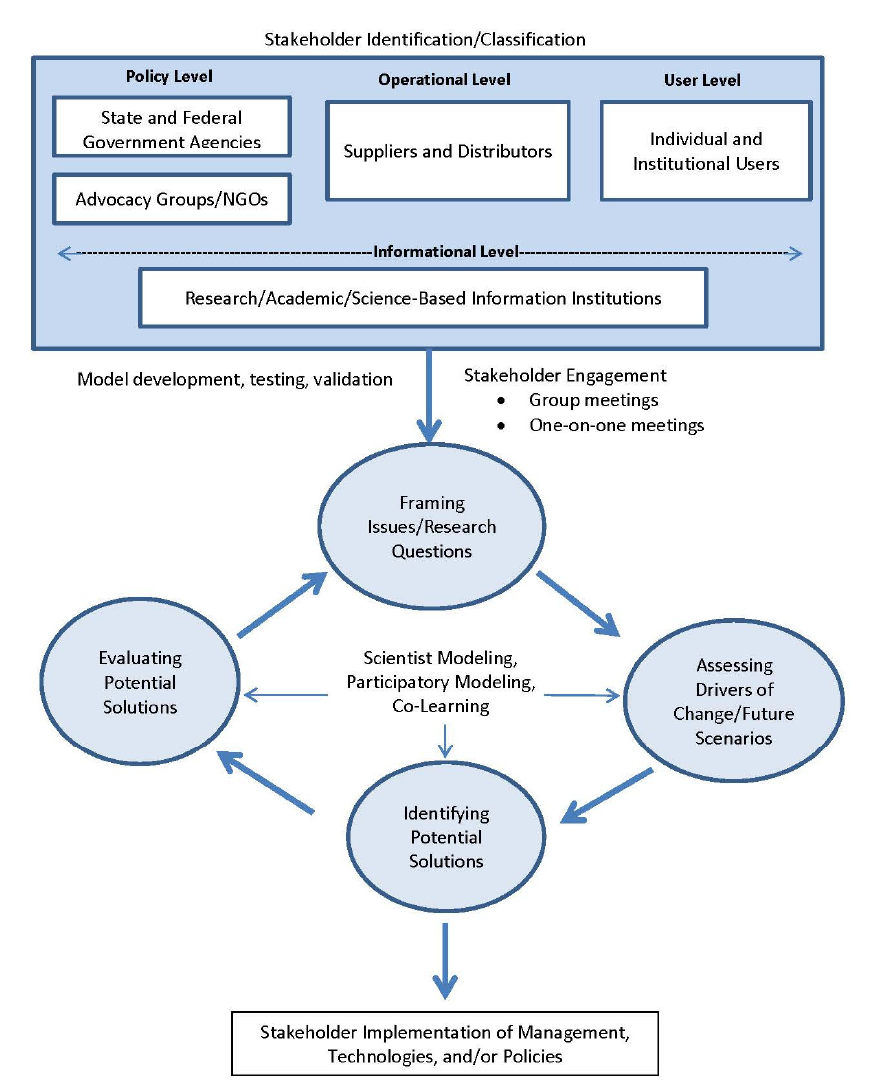
Figure 2. Theoretical framework for stakeholder identification and engagement in a participatory modeling process.